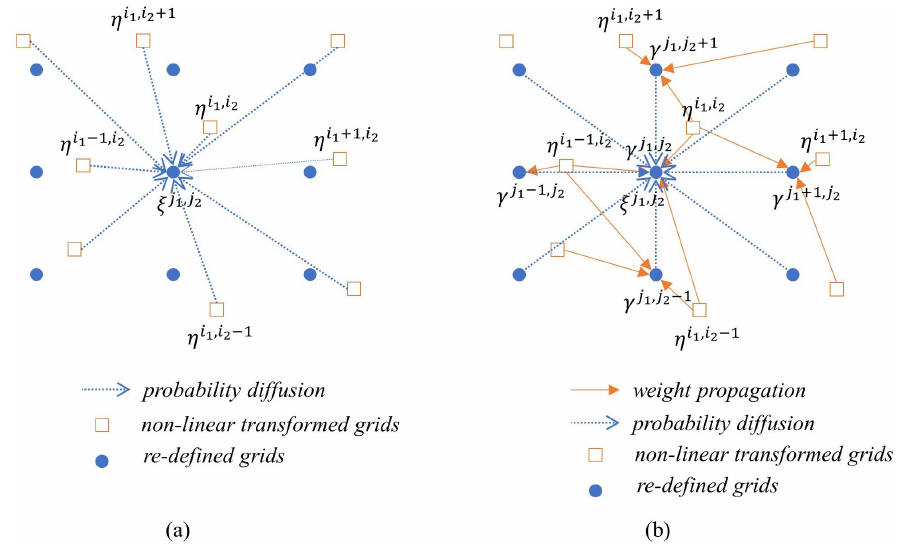
Figure 2. Comparison of the probability diffusion processes between the conventional and the proposed PMF ( a ) Conventional PMF ( b ) Proposed